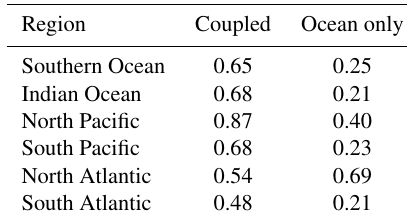
Table 3. Average mean differences ( Z 1 yr ) and average